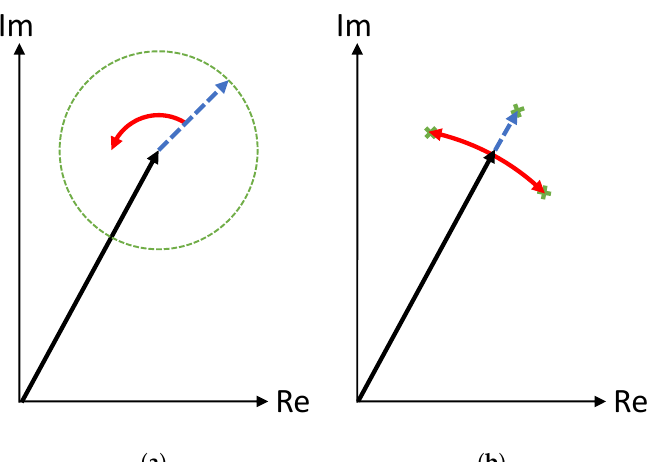
Figure 17. ( a ) Additive error model: SAR signal (black vector) imposed with additive RFI (blue-dashed vector). A phase change of the interferer (red) causes the measured signal to be within the green-dashed circle. The resulting gain error depends on both RFI amplitude and phase. The resulting phase error depends on amplitude and phase as well. ( b ) Multiplicative error model: SAR signal (black vector) that is affected by multiplicative gain error (blue-dashed vector) and multiplicative phase error (red). The resulting gain error depends on the multiplicative gain, the resulting phase error on the multiplicative phase.